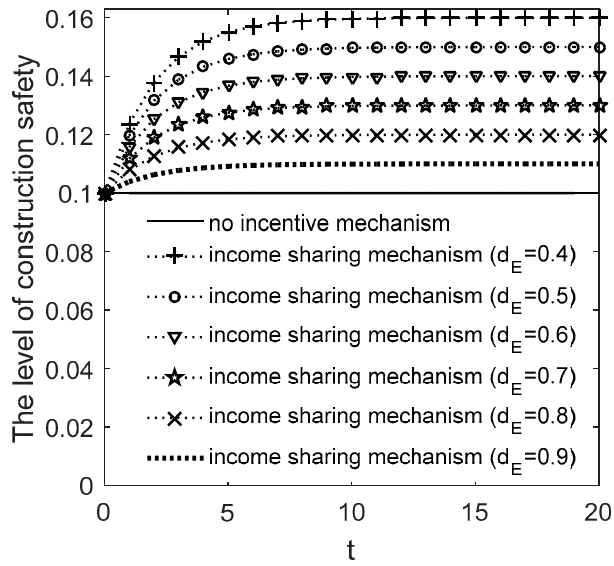
Figure 3. The impact of d E on the level of construction safety.